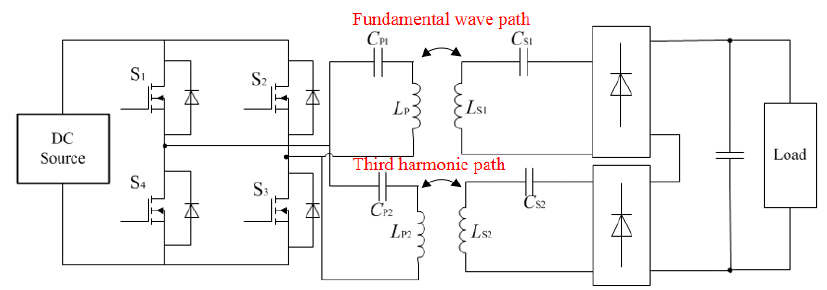
Figure 4. Fundamental-harmonic dual-path wireless power transfer.